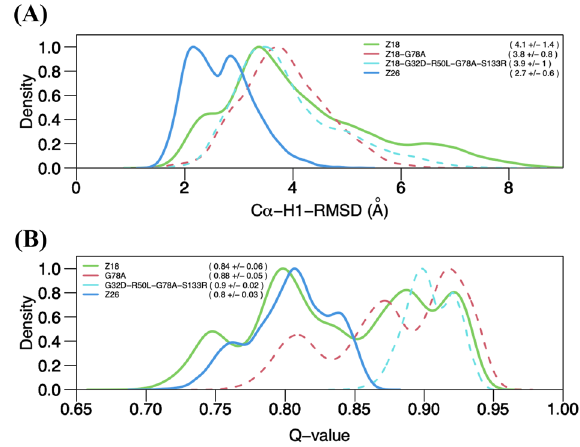
Figure 3. Dynamics of CDR-H1 of Z18 and Z26 differ. Kernel density estimation of ( A ) Cα-RMSDs of CDR- H1 and ( B ) Q-values computed based on the last 500 ns simulations for Z18, Z18-G78A, Z18-G32D/R50L/ G78A/S133R, and Z26. The last 500 ns trajectories of each system were merged in each plot. Averages and standard deviations are indicated in parenthesis. Y-axis was normalized to a range between 0 and 1 for each